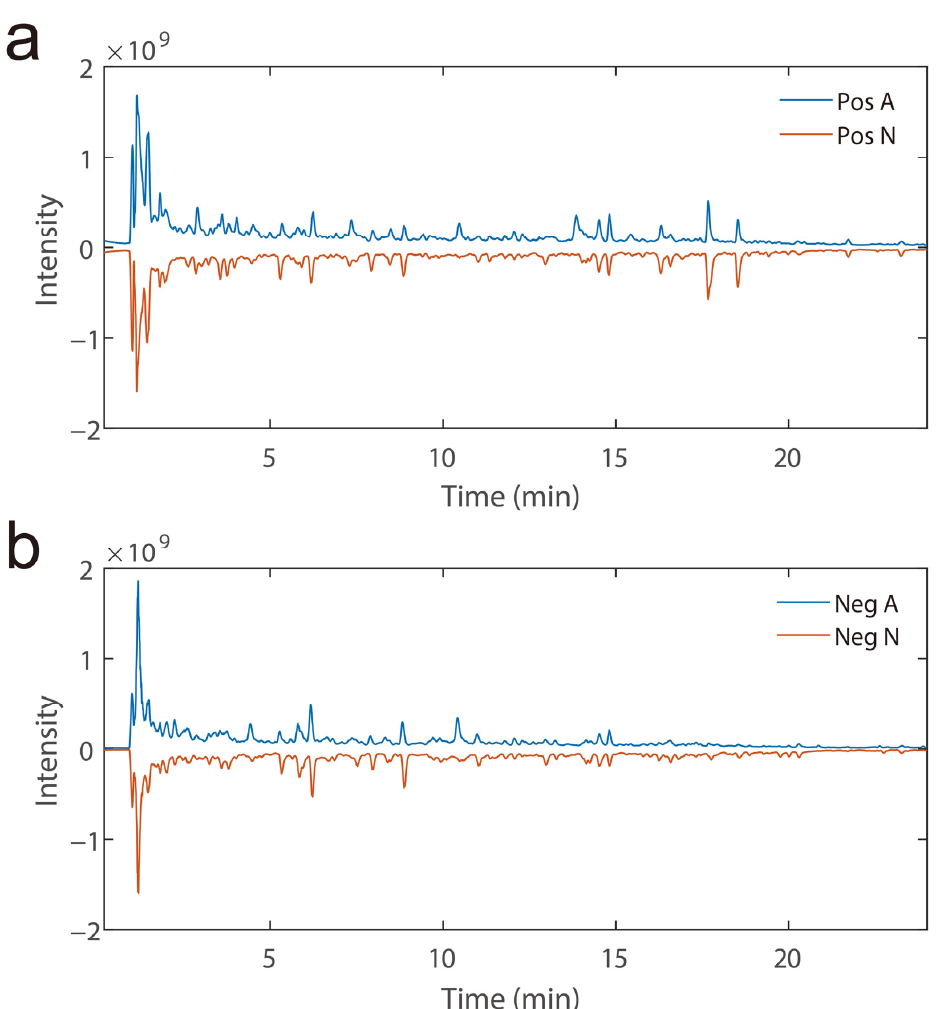
Figure 1. ( a ) Comparison of the total ion chromatograms in the positive (Pos) for oak barrel aged (A) and non-oak barrel aged (N) wine samples. ( b ) Comparison of the total ion chromatograms in the negative (Neg) for oak barrel aged (A) and non-oak barrel aged (N) wine samples. To obtain the data matrix, including retention time (RT), m / z , and peak intensity for each sample, the collected raw data were imported into the AntDAS [21] data automation parsing software for data analysis. A list of compound information of 39,104 × 74 was obtained in the positive ionization mode, where 39,104 is the number of EIC peaks and 74 is the number of samples (containing sixty-six samples and eight QCs). For the same samples collected in the negative ionization mode, a data matrix of 31,944 × 74 was obtained. In order to demonstrate the potential of AntDAS peak extraction, [M+H] + and [M − H] − peaks were extracted from the compounds with an accurate molecular weight of 304.0583. The results are shown in Figure 2a, b. Figure 2a shows the extraction of the m / z 305.0655 peaks under positive ions from which it is clear that 21 EIC peaks were well extracted. Another peak extraction at m / z 303.0560 under negative ions is shown in Figure 2b, where 15 EIC peaks were extracted. On the whole, most of the EIC peaks basically achieved baseline separation. As shown in the local magnification of the peak extraction results in Figure 2a, b, AntDAS demonstrates the ability to achieve a more reasonable segmentation of the overlapping signals of the compounds in both positive and negative ion modes. On